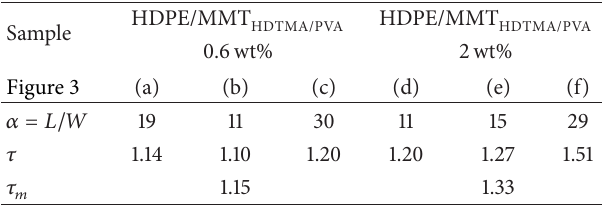
Table 4: Mean filler aspect ratio ( 𝛼 ) and tortuosity of material